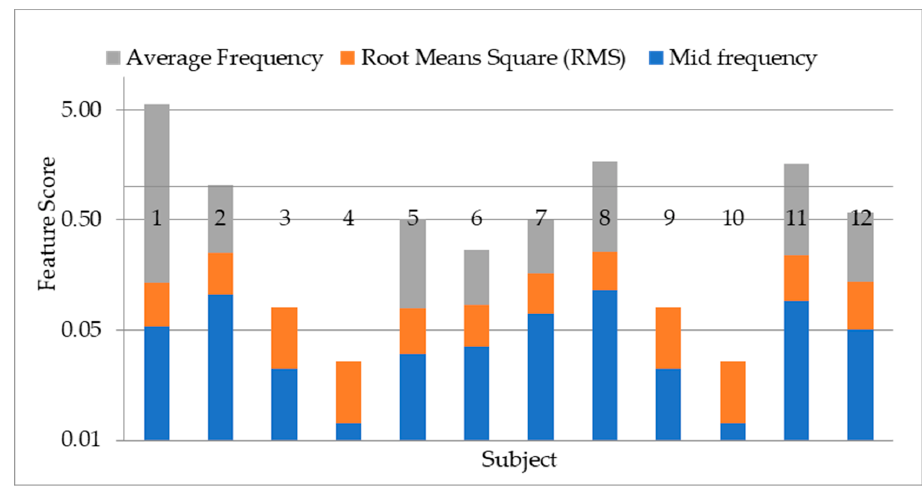
Figure 11. Showing variation of mid frequency, root mean square and average frequency on twelve subjects.